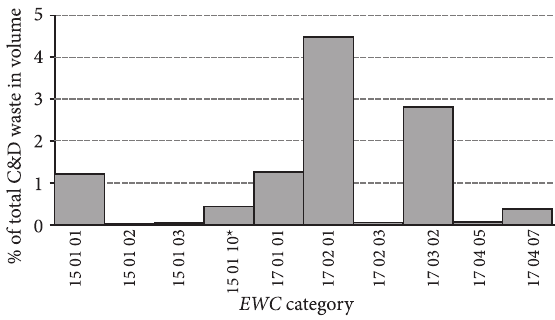
Fig. 1. Percentage of each C&D waste category generated